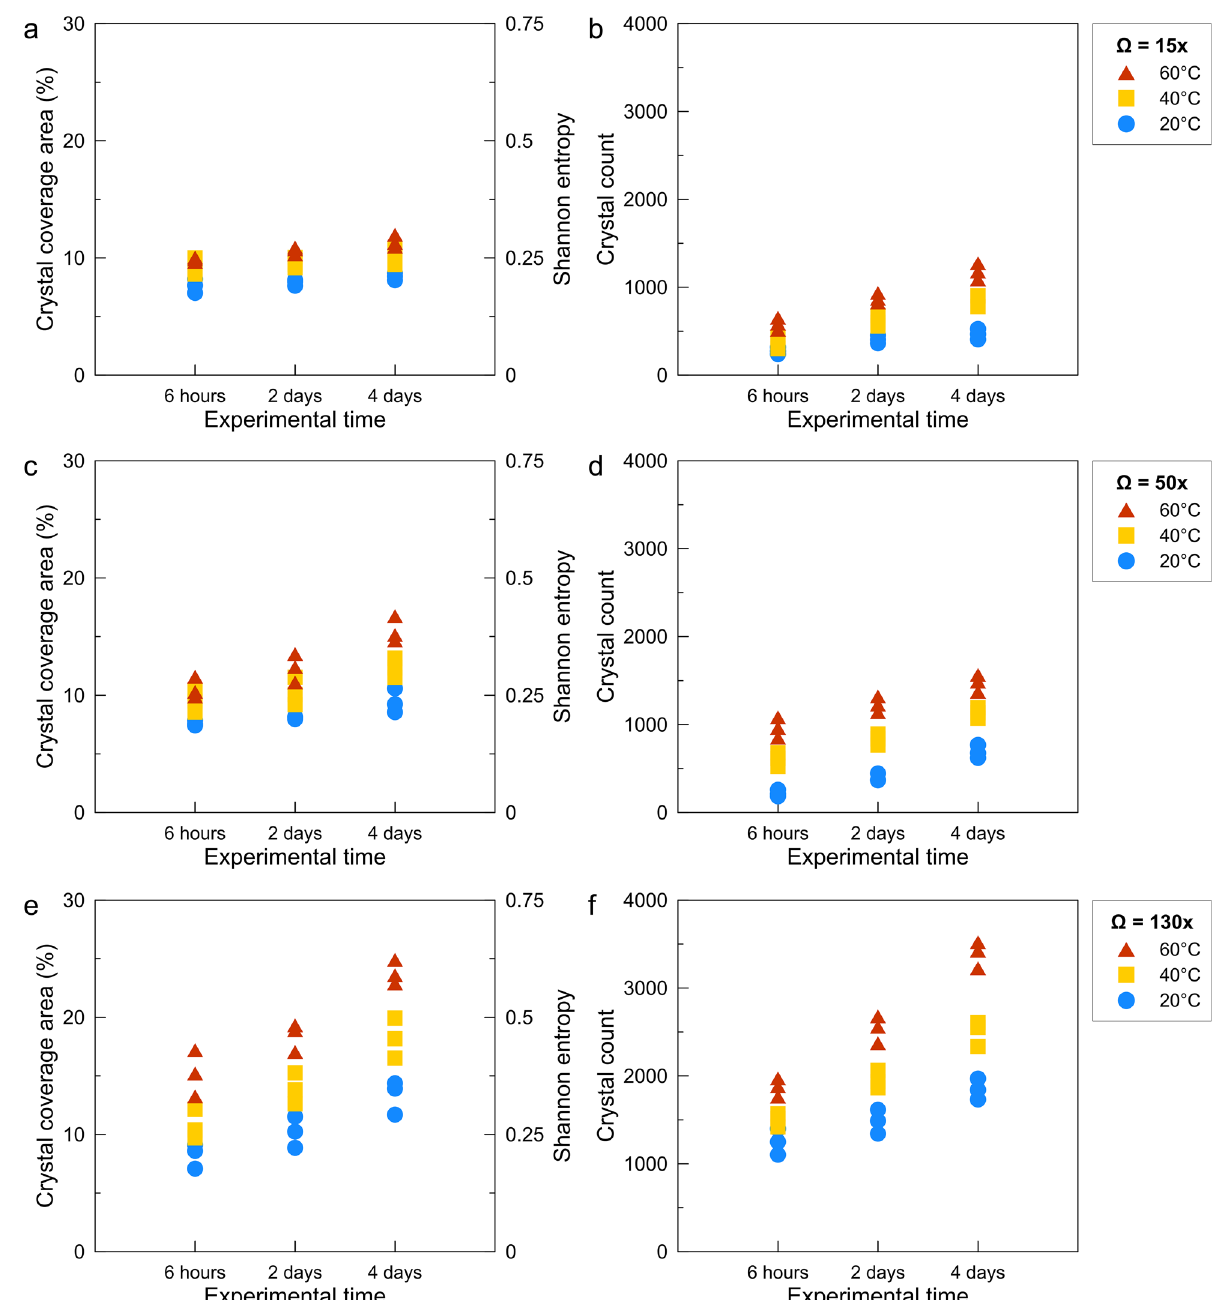
Figure 2. Total coverage area (%), computed Shannon entropy, and the number of the precipitated crystals plotted against the experimental sampling time. (top) 15 × (middle) 50 ×, and (bottom) 130 × supersaturation experiments as a function of testing temperatures. The results are derived from digital image processing of three random locations within each mosaic